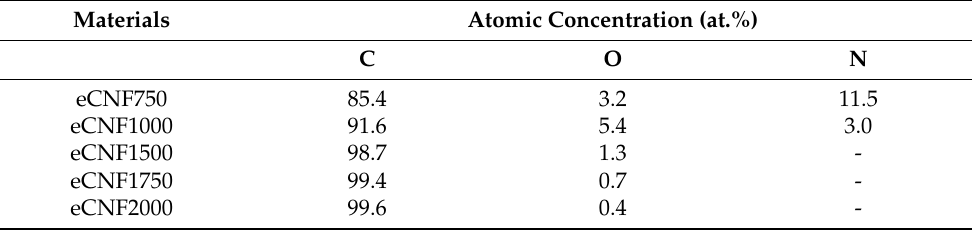
Table 1. Elemental composition from XPS analysis of CNFs after various thermal treatments. Materials